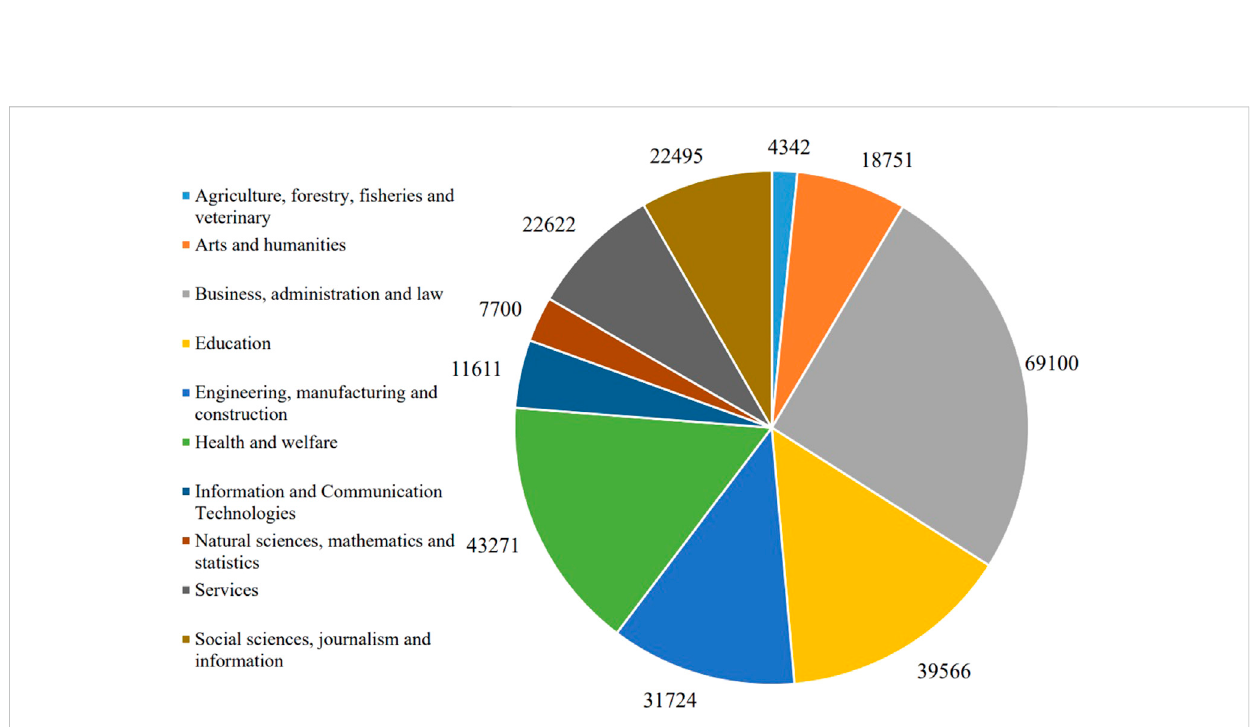
Frontiers in Environmental